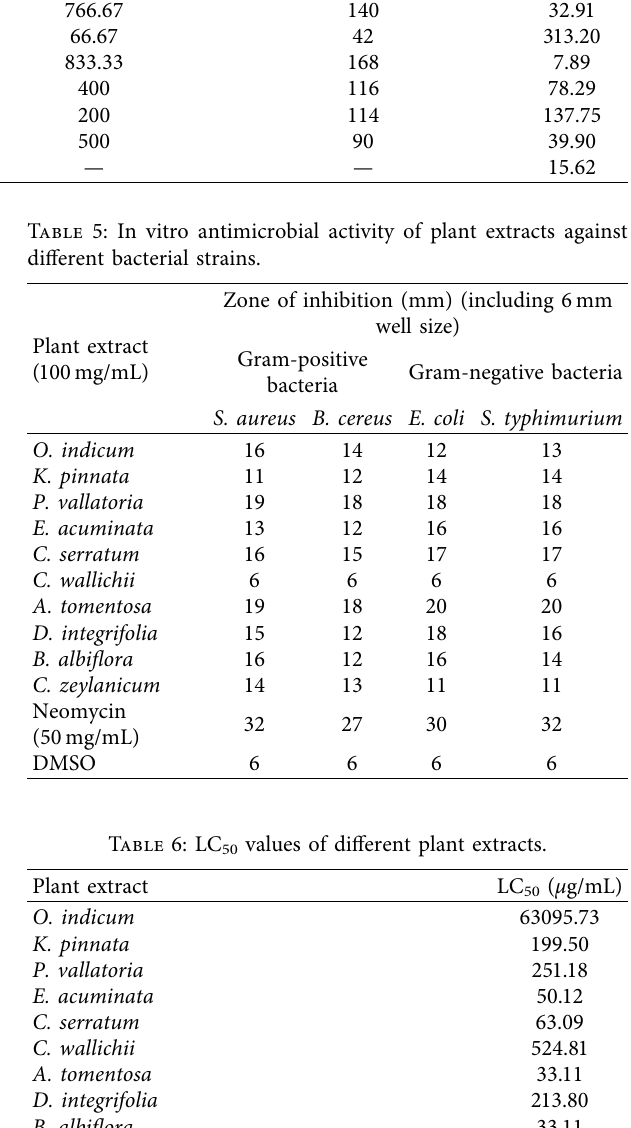
50 values of ten plant species and